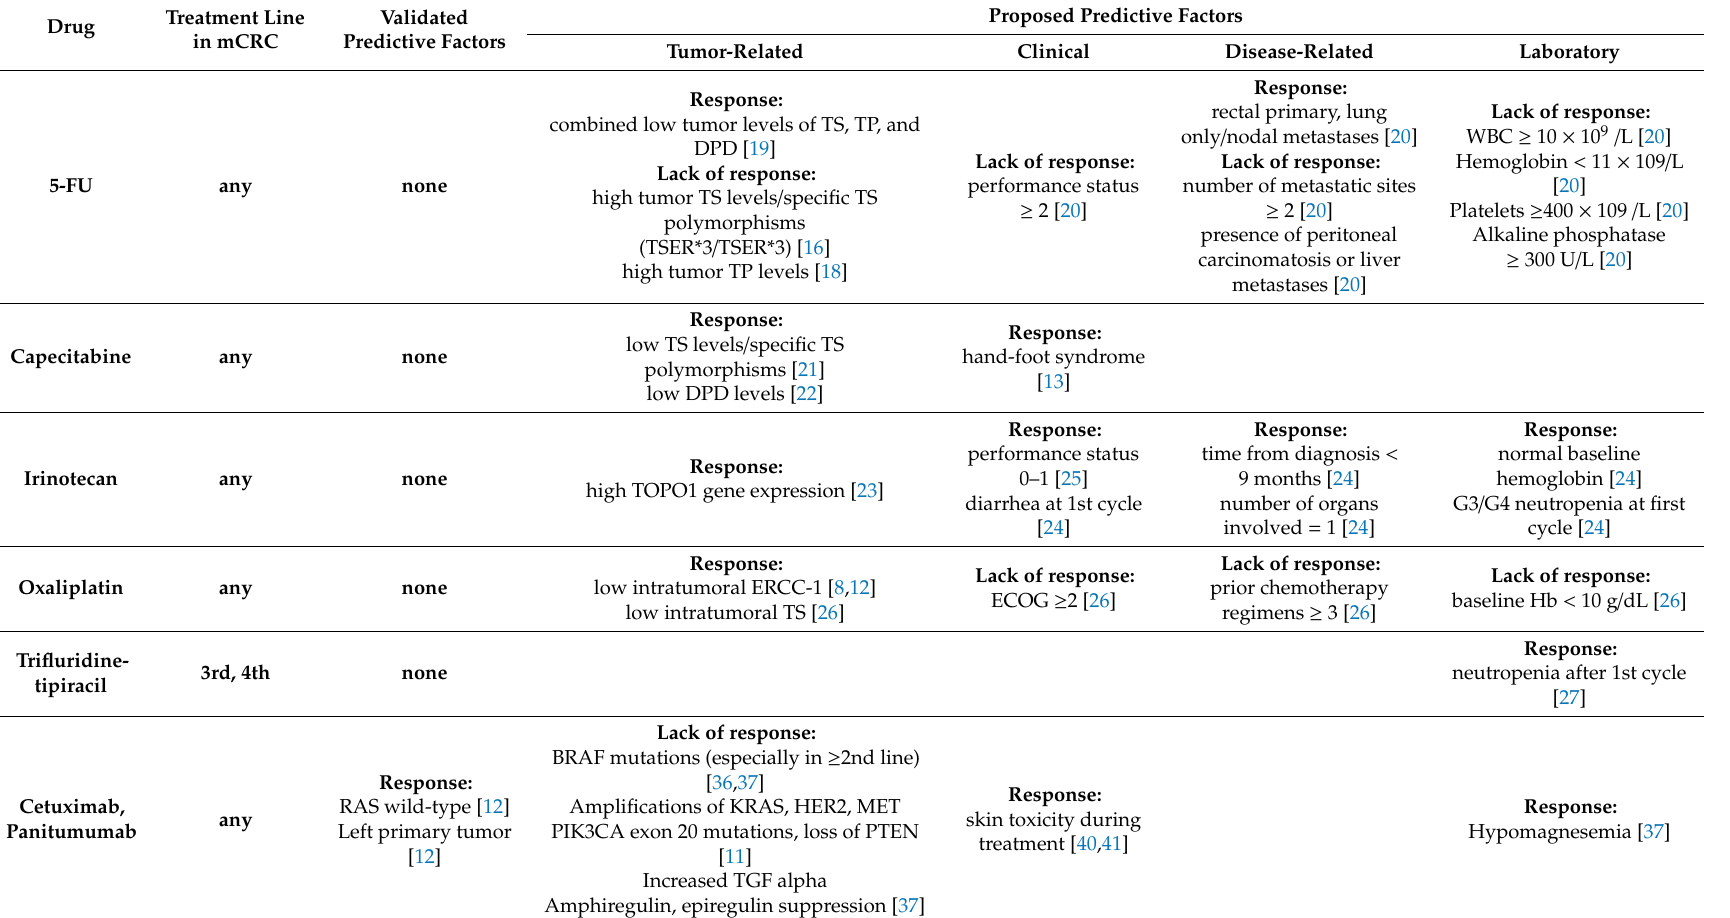
Table 1. Validated and proposed predictive factors for response to systemic treatments in metastatic colorectal